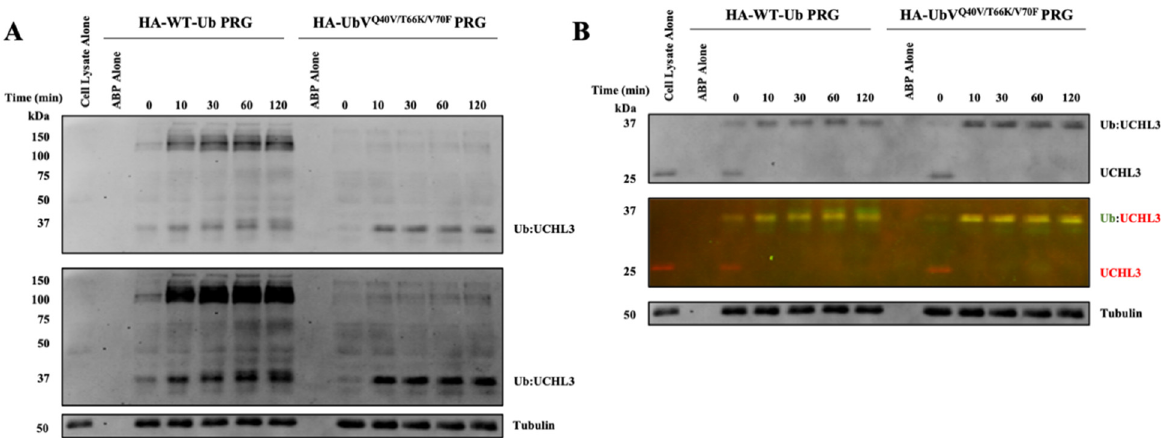
Figure 5. Time-dependent Western blot for Ub-ABPs. HA-WT-Ub-PRG and HA-UbV Q40V/T66K/V70F - PRG, 5 µM, were both dosed into MDA-MB-231 cell lysates (total protein concentration of 0.5 mg/mL). Samples were tested at the indicated time points. ( A ) Anti-HA Western blot indicates several non-specific covalent adducts formed by HA-WT-Ub-PRG while the HA-UbV Q40V/T66K/V70F -PRG displayed significantly reduced non-specific binding. The blots were imaged with both a normal exposure (top) and dark exposure (bottom) to identify lower concentration or faint bands. ( B ) Anti-UCHL3 and anti-HA colocalization blot that displays the gel-shift of the UCHL3-Ub adducts over time.